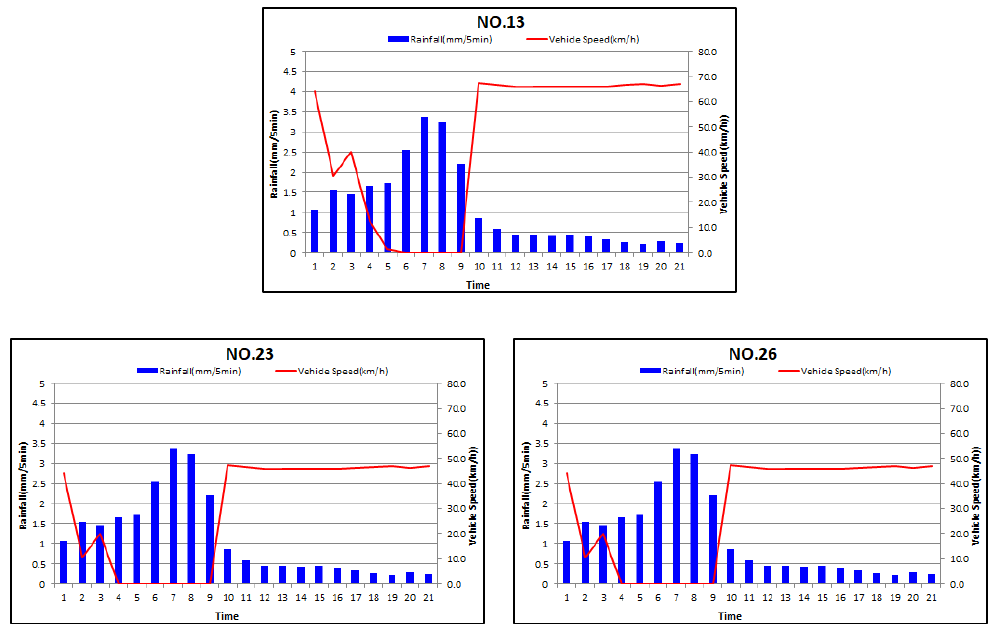
Figure 18. Rainfall – vehicle speed relationship. Figure 18. Rainfall–vehicle speed relationship.